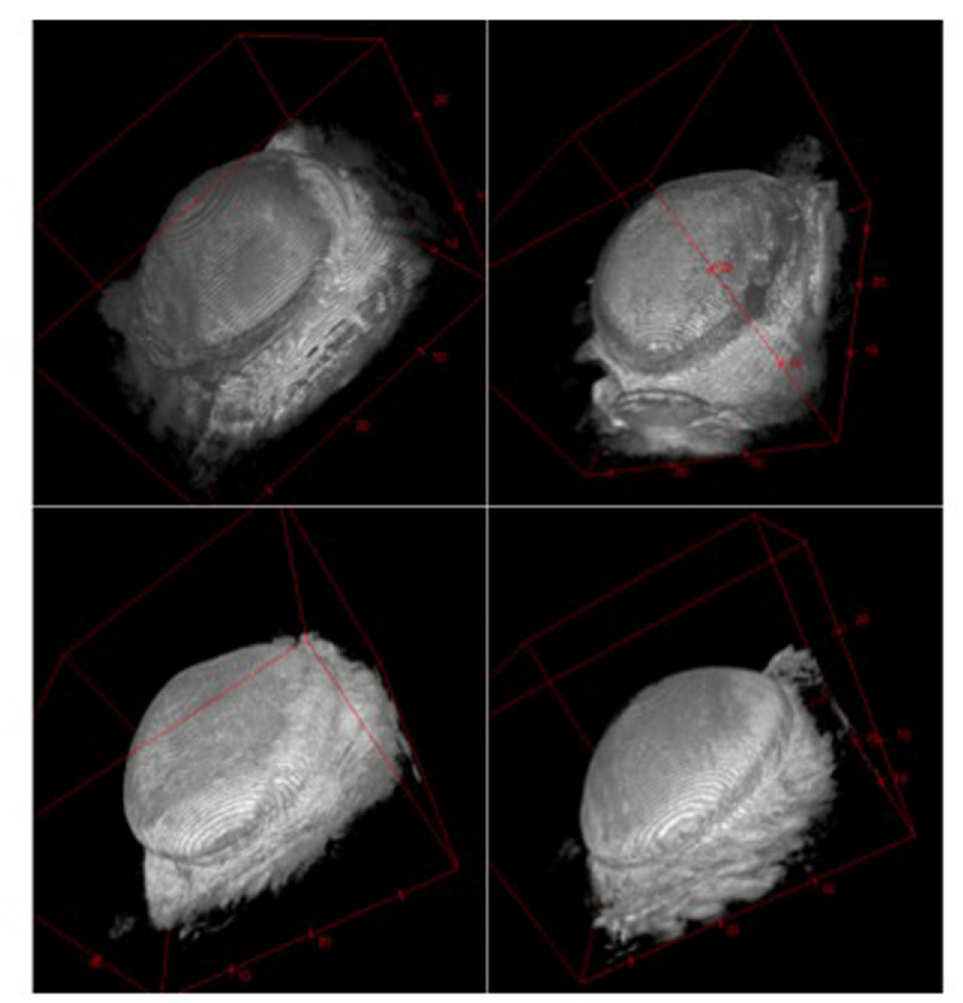
Fig 12. 3D reconstruction of 7-Tesla MRI scans of smooth implants on day 60 (60s, upper left), textured implants on day 60 (60t, upper right), smooth implants on day 120 (120s, lower left) and textured implants on day 120 (120t, lower right).